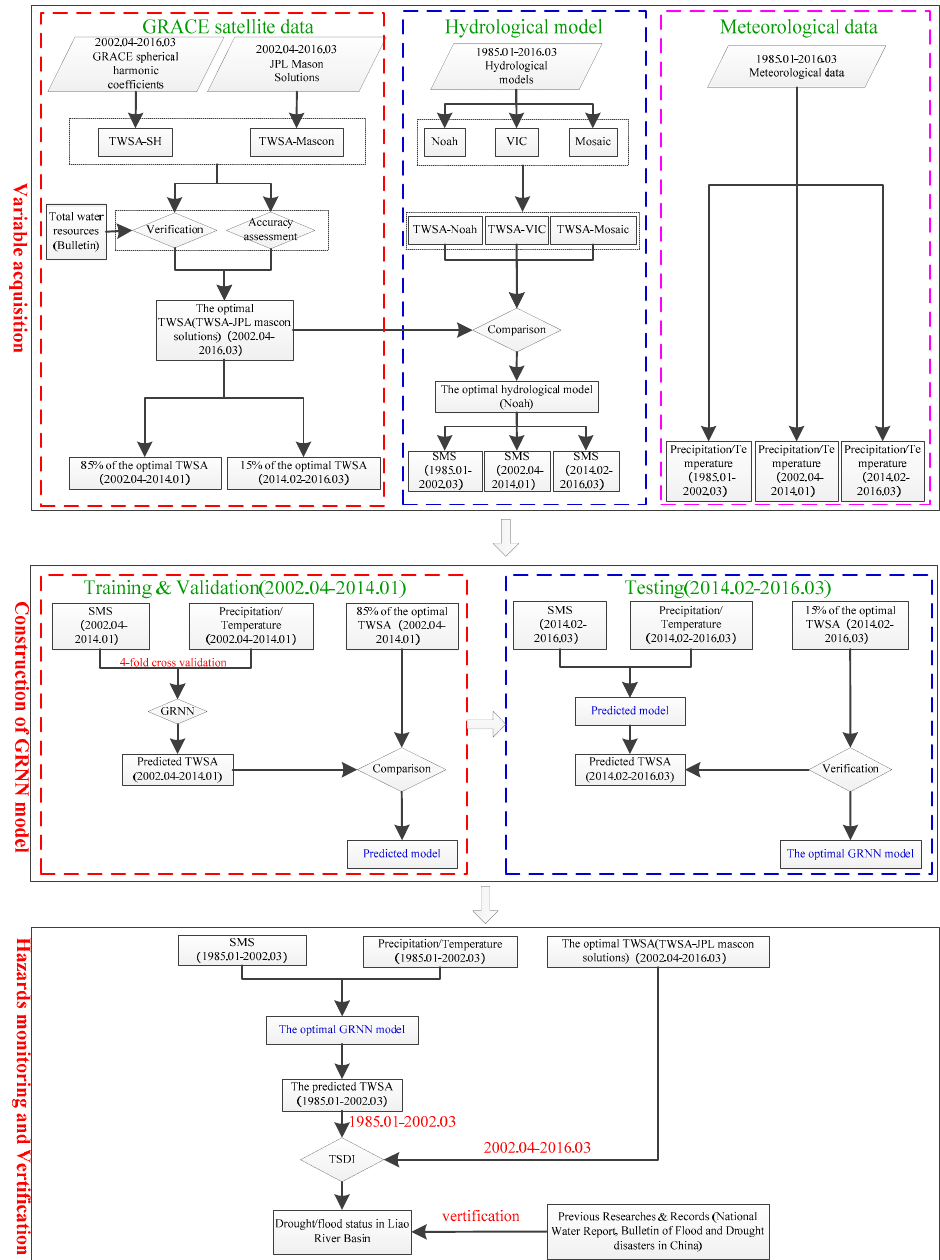
Figure 1. Flowchart of drought and flood disaster monitoring in the Liao River Basin. Note: the time span of the hydrological model and meteorological data from January 1985 to March 2016 was divided into three parts: the first part was from January 1985 to March 2002, the second part was from April 2002 to January 2014, and the last part was from February 2014 to March 2016. By contrast, the GRACE satellite data from April 2002 to March 2016 were divided into two parts: one was from April 2002 to January 2014, and the other was from February 2014 to March 2016. The part from April 2002 to January 2014 was used for training (75%) and validating (25%) the GRNN model; during this process, 4-fold cross validation was applied. However, the part from February 2014 to March 2016 was utilized for testing the predicted model to avoid overfitting. The remaining part of the hydrological model and meteorological data, from January 1985 to March 2002, was used as the input variables of the optimal GRNN model to obtain the TWSA from January 1985 to March